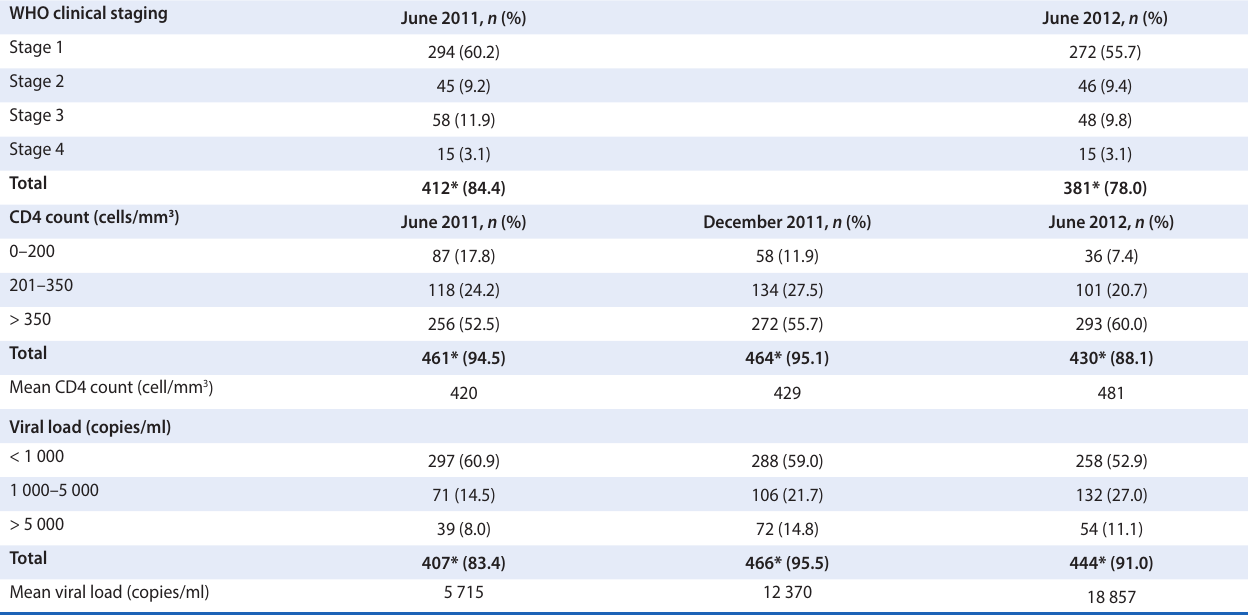
Table 2: Trend of World Health Organization staging, CD4 count and viral load from June 2011 to June 2012 ( n = 488) WHO clinical